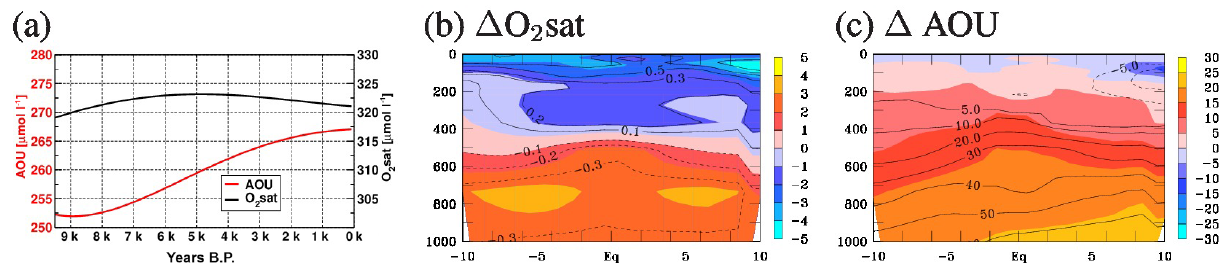
Figure 13. (a) Time series of AOU and O 2 sat in the EEP (region as in Fig. 12, but for 100–800m depth), and (b, c) meridional sections of zonal mean differences of late Holocene minus early Holocene for (b) O 2 sat (shading, µmolL − 1 ) and temperature (contours, ◦ C) and (c) AOU (shading, µmolL − 1 ) and water mass age (contours, years). The contour interval for temperature is 0.1 ◦ C from − 0.3 to 0.3 ◦ C, with additional lines for 0.5, 0.7, and 1 ◦ C. The contour interval for water mass age is 10 years from − 10 to 60 years, with additional lines at − 5 and 5 years. Zero contours are omitted.